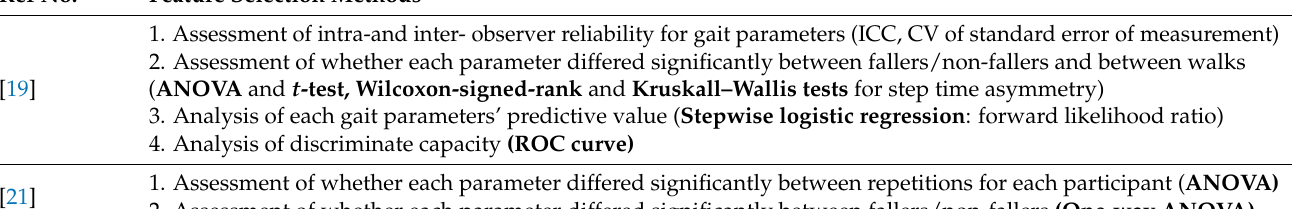
Figure A3. Number of sensors per body location for articles in Tables 5 and 6, per publication year.